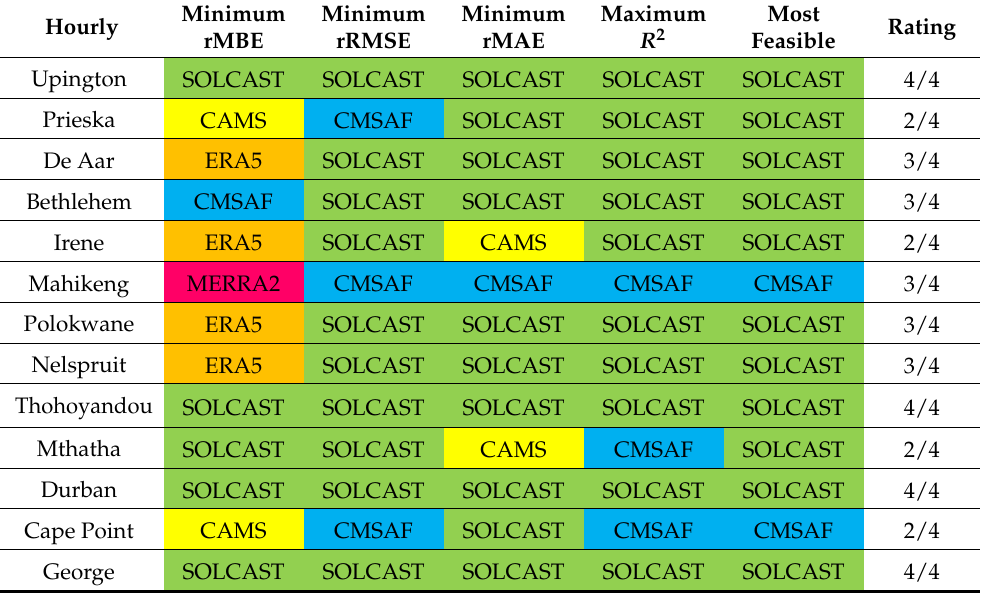
Table 7. Best performing gridded dataset per hourly metric, most feasible model, and level of performance (rating). The colors were used to show the best performing gridded dataset based on the hourly statical metric per station and the most feasible dataset per station based level of rating out of 4 (the number of statistical metrics used). Green represents SOLCAST, yellow CAMS, blue CMSAF, orange ERA5, and red